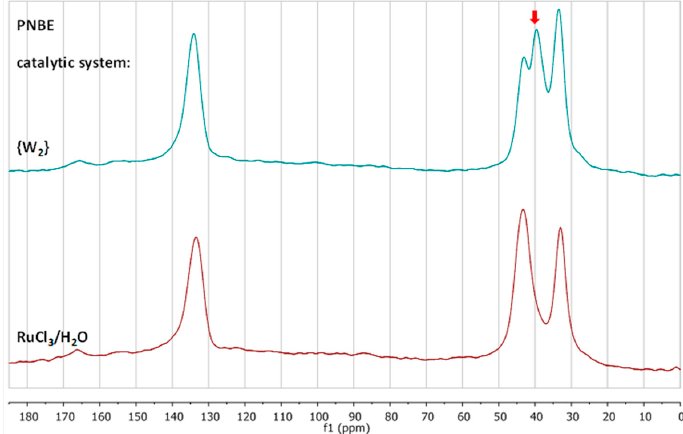
Figure 2. 13 C CPMAS NMR spectra of PNBE obtained with catalytic systems {W 2 } and RuCl 3 /H 2 O, as indicated. The peak assigned to cis segments of the polymer chain is indicated with an arrow.